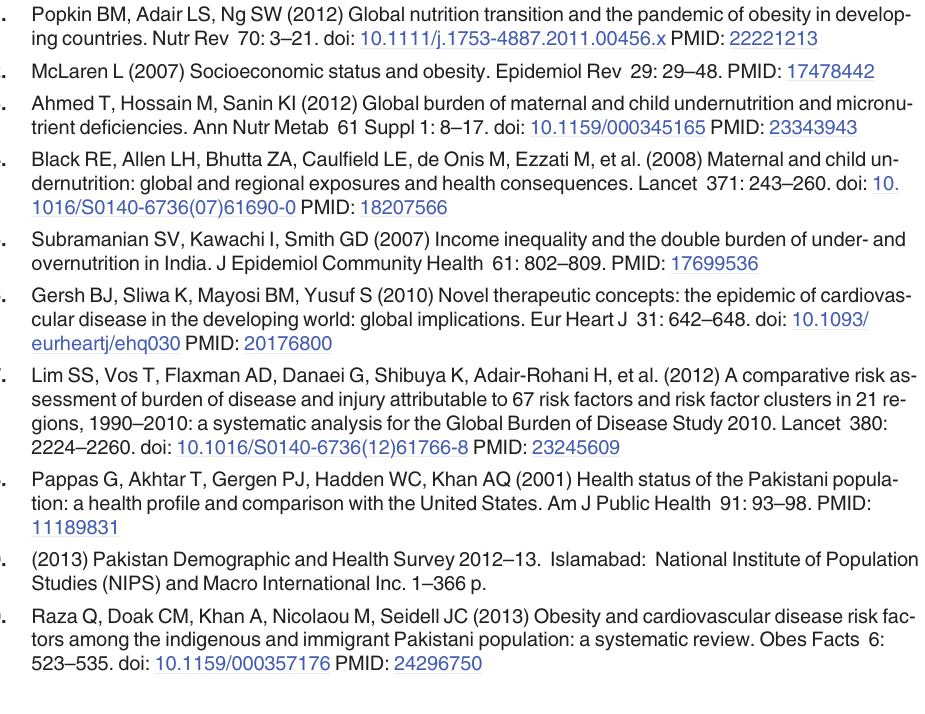
S1 Fig. Distribution of BMI among women by wealth quintiles. S1 Table. Univariable models for association socio-economic position and other character- istics with categories of BMI. S2 Table. Multivariable model presenting interaction of household socio-economic posi- tion and urbanicity. S3 Table. Multivariable model presenting interaction of household socio-economic posi- tion and community socio-economic